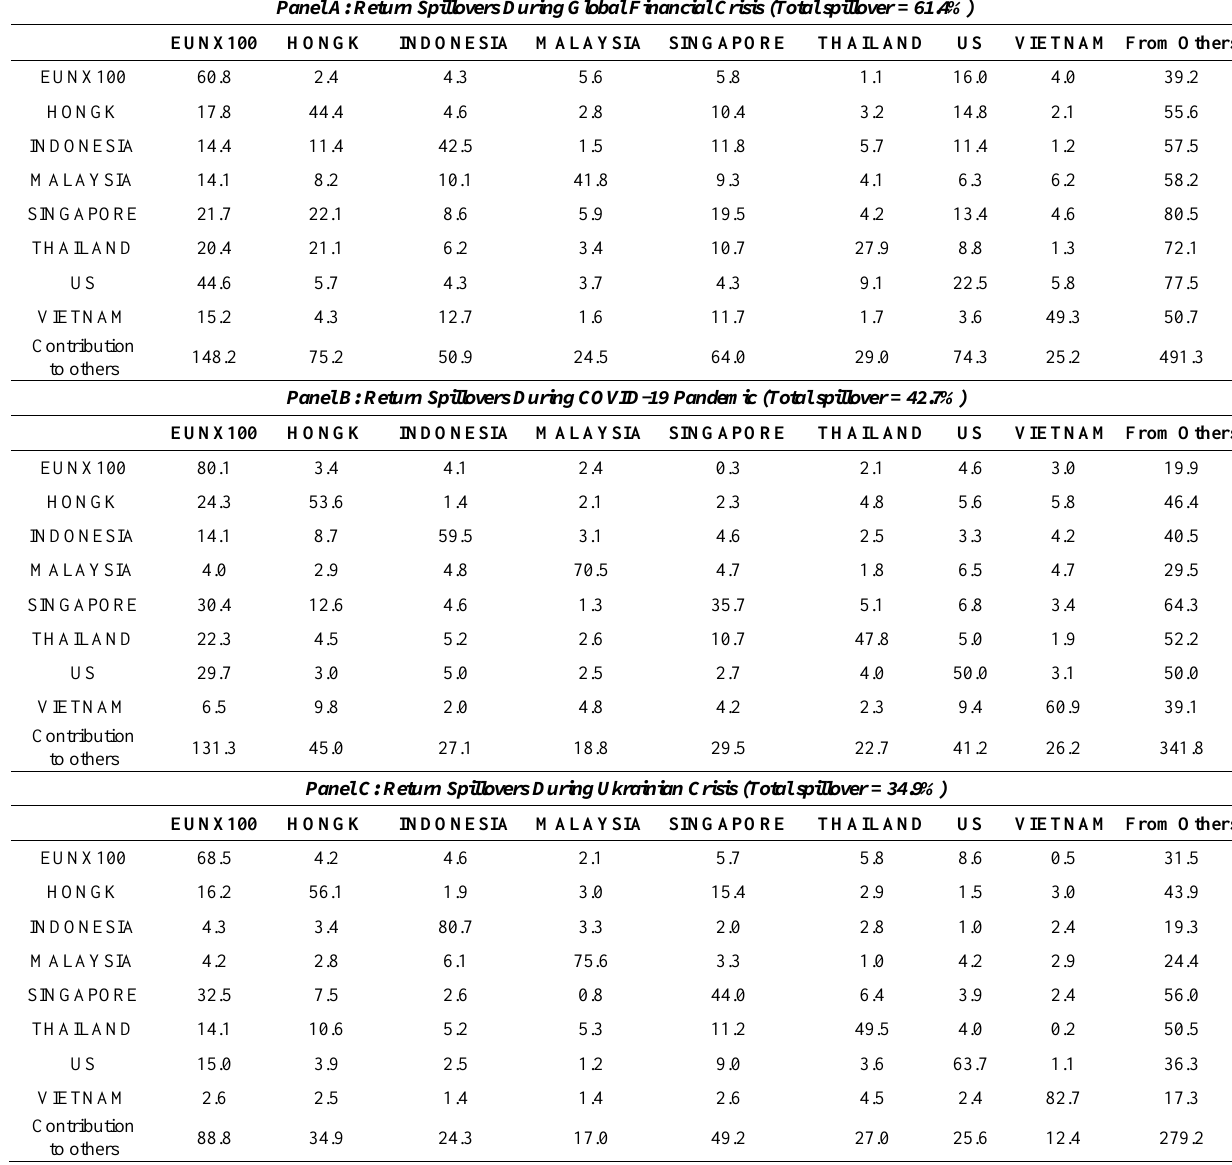
Table 2. Diebold and Yilmaz Test Results for Return Spillovers during the Three Sub-periods Panel A: Return Spillovers During Global Financial Crisis (Total spillover =